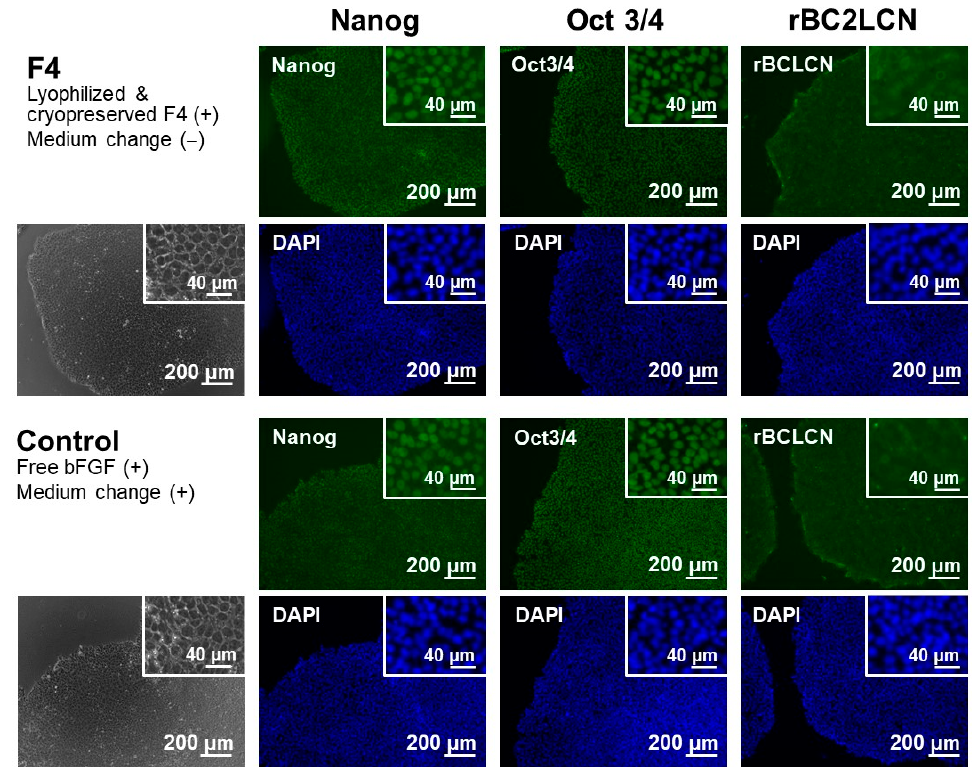
Figure 11. Phase contrast (leftmost column) and fluorescence (right 3 columns) microscopic images of human iPSCs on Day 3 in medium-change-free continuous culture with the lyophilized and cryopreserved (3 months) F4 membrane (F4 group; upper 2 rows) or in standard culture using bFGF-containing medium with daily medium refreshment (control group; lower 2 rows). The iPSCs were stained with FITC (green)-conjugated anti-Nanog, anti-Oct 3/4, and rBC2LCN, and their nuclei were counterstained with DAPI (blue). Insets show higher magnification images.